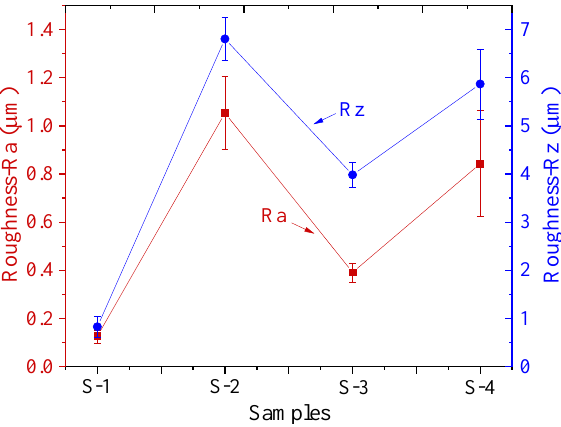
Figure 3. The surface roughness of NiTi alloy before and after laser nitriding.